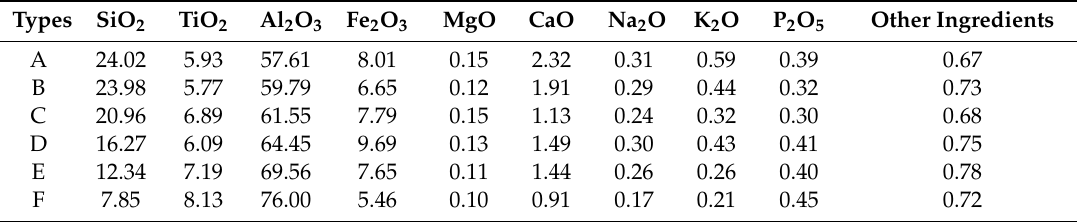
Table 4. Technical properties of different types of bauxite.